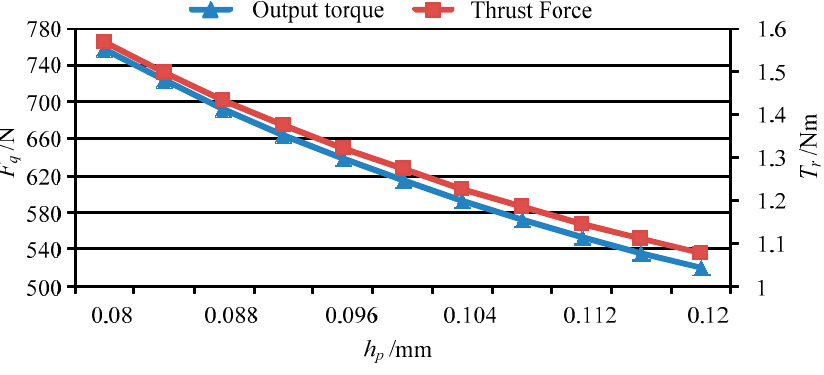
Figure 16. The output torque and thrust force vary with h p .